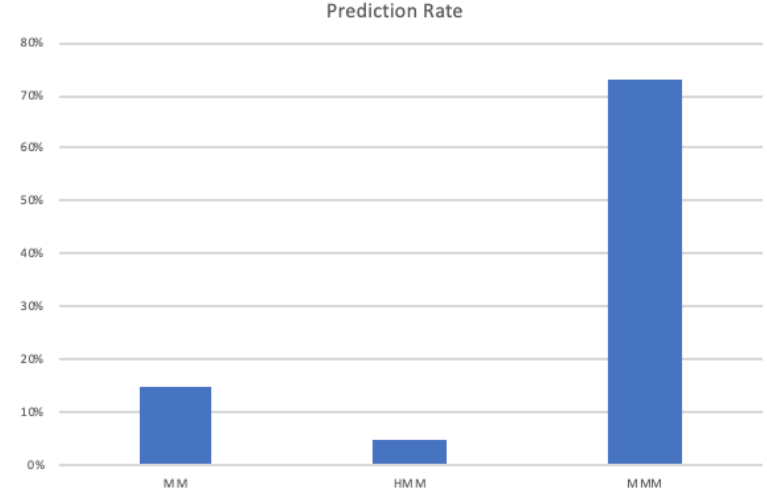
Figure 14. Mixed Markov–Chain Model (MMM) vs. Hidden Markon Model (HMM) vs. Markov Model (MM) step prediction rates in Reference